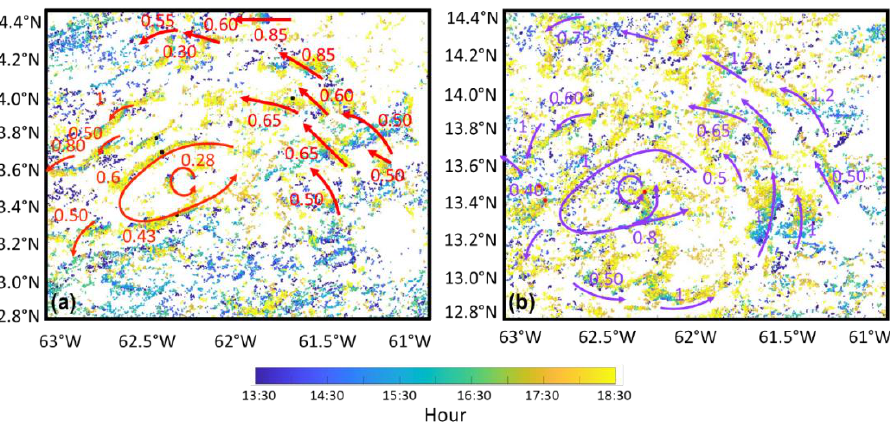
Figure 9. Sargassum aggregations motion (speed and direction) calculated from GOES hourly data over the course of 5 h; the arrows highlight the occurrence of an eddy (in the west part of the image at 62.2° W) and a northwestward drift (in the east part of the image at 61.5° W): ( a ) On 8 August 2018 (red arrows) and ( b ) on 9 August 2018 (purple arrows).